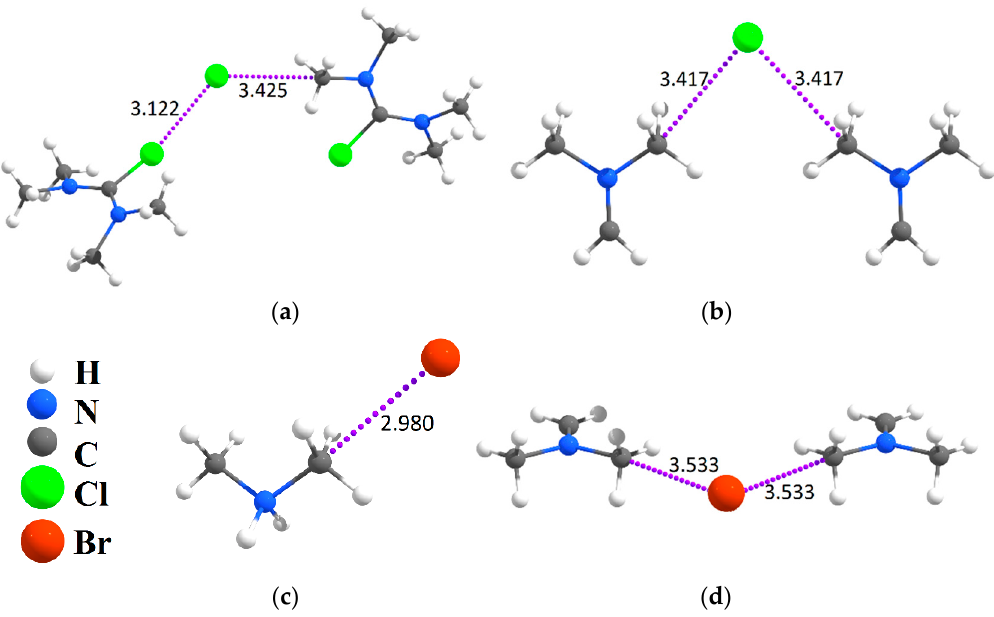
Figure 2. Fragments of structures with tetrel bonds and other non-covalent interactions in crystals LONGEB ( a ), VAPREJ ( b ), POSTUM02 ( c ), LILLOH ( d ). The interatomic distances are given in Angstroms. Table 1. Experimental and calculated tetrel and C–Y bond lengths, D (Å), angles Hal − ···C–Y, θ and calculated electron density, ρ (r bcp ) (a.u.) at bond critical points for considered crystals.